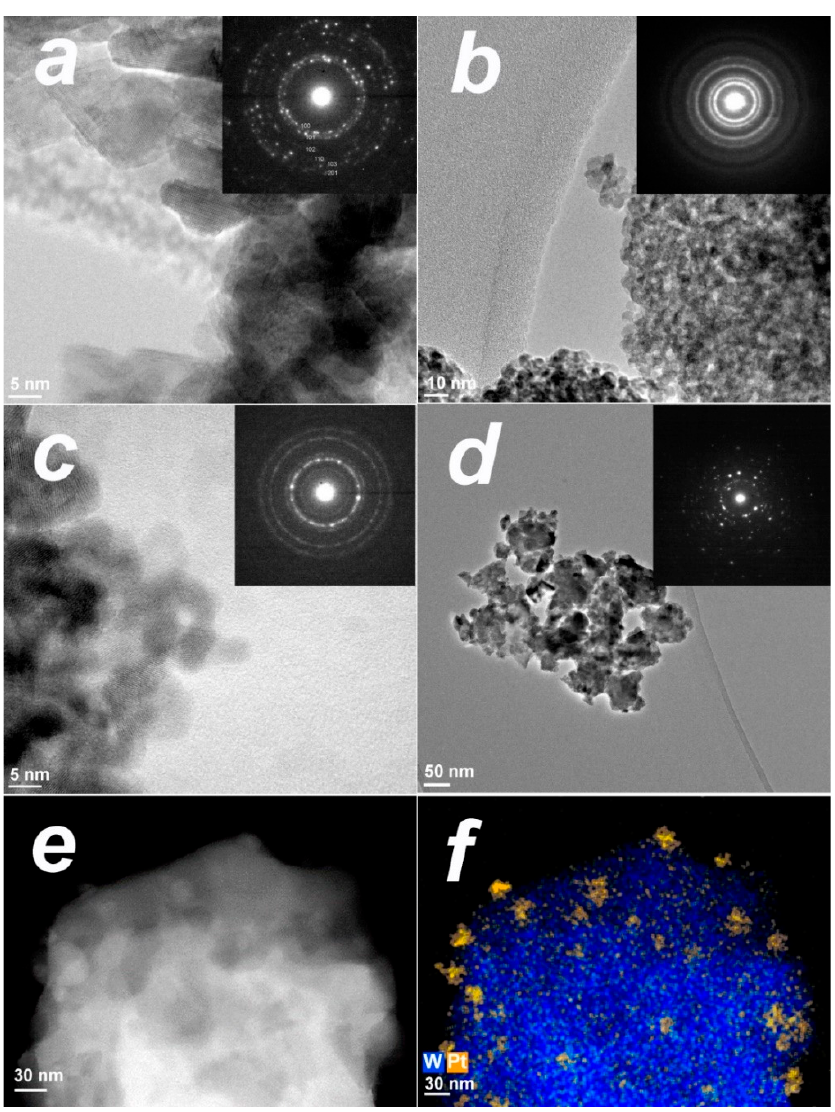
Figure 1. HRTEM images of nanocomposites ZnO/PtO x ( a ), SnO 2 /PtO x ( b ), and In 2 O 3 /PtO x ( c ); TEM image of TiO 2 /PtO x ( d ); HAADF-STEM micrograph of WO 3 /PtO x ( e ), and overlaid EDX map of W L-signal (blue) and Pt L-signal (orange) ( f ).